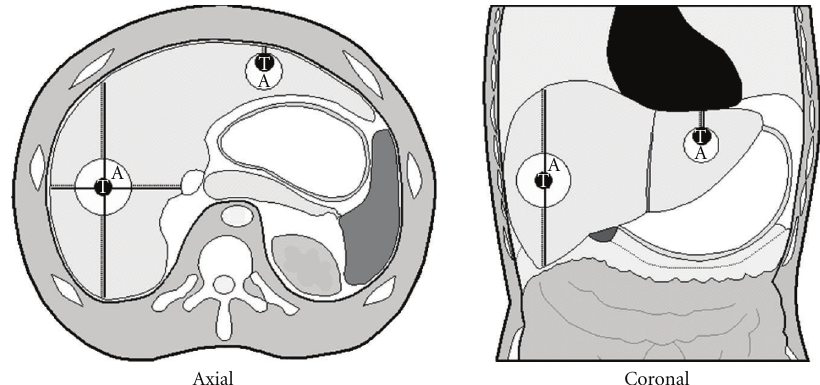
Figure 1: Explanation of the method of measurement. Schematic representation of the method of measurement of the ablation zone. Figure 1 representing the axial and coronal view respectively of the tumour (black circle with white T) and the ablation zone (white circle with black A). Ablative margins were calculated as follows. The distance from the edge of the tumour to the surface of the liver was measured in all six directions on the pre-RFA scan (continuous line). The same measurements were performed for the post-RFA scan from the edge of the ablation zone scan to the surface of the liver (dotted line). The ablative margins are the di ff erence between both distances. The tumour in the left liver lobe is considered to be incompletely ablated because in one of the six directions the di ff erence between both distances is zero.